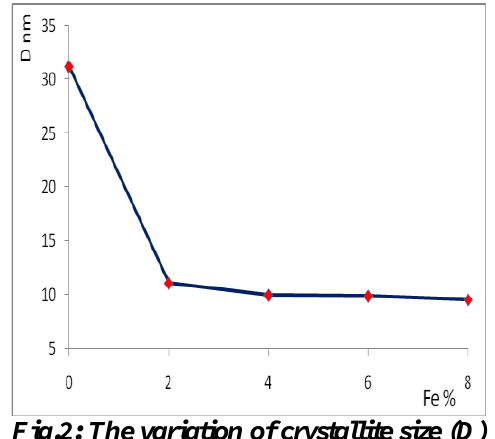
Fig.2: The variation of crystallite size (D) for ZnO thin film with Fe doping concentrations.